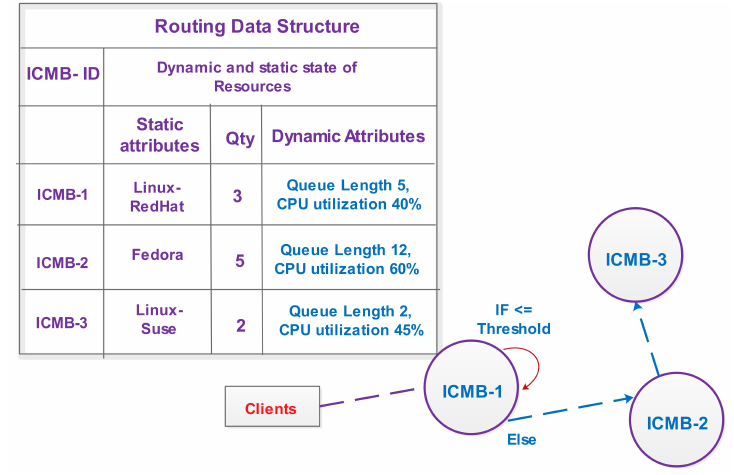
Figure 3. Meta-brokering level data